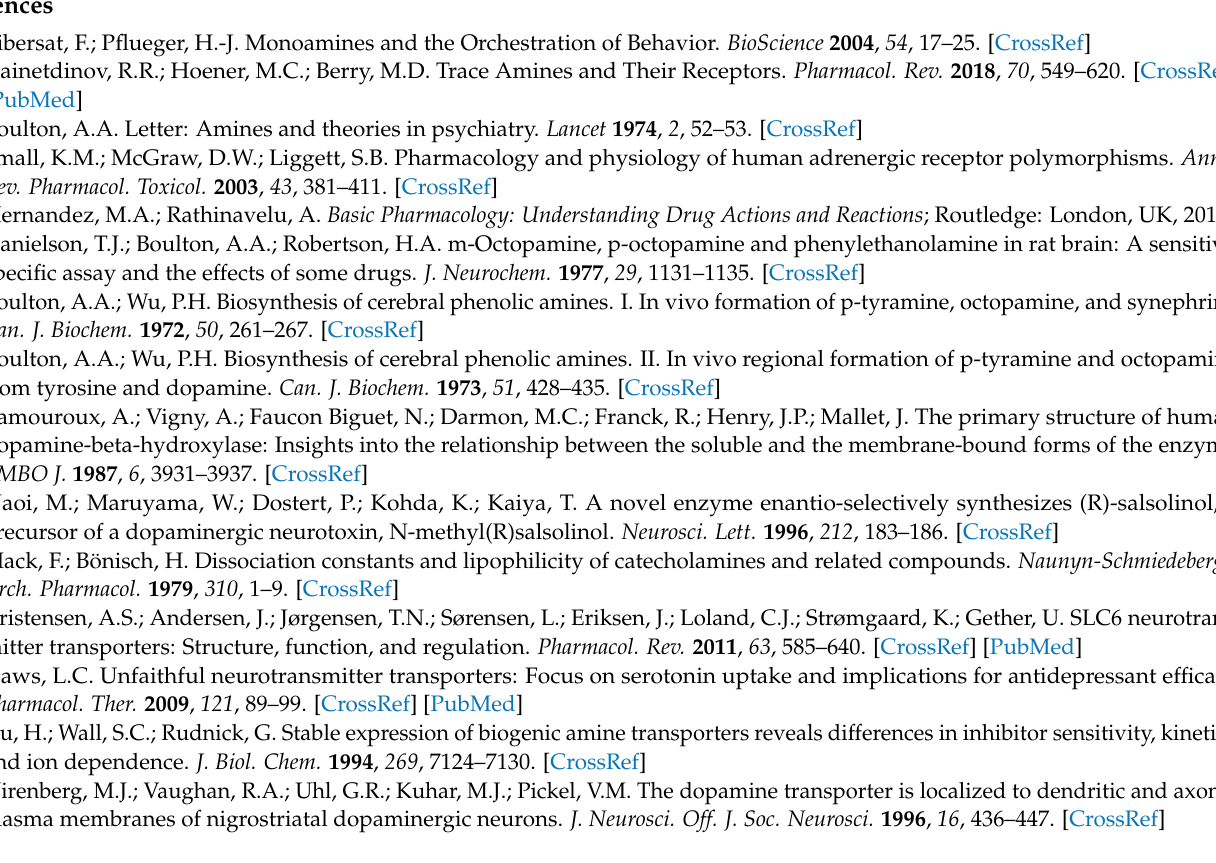
Figure S3: Net uptake curves of the serotonin transporter (SERT), Figure S4: Net uptake curves of the organic cation transporter 1 (OCT1), Figure S5: Net uptake curves of the organic cation transporter 2 (OCT2), Figure S6: Net uptake curves of the organic cation transporter 3 (OCT3); Table S1: HPLC conditions for chiral separation of investigated substances, Table S2: Mass spectrometry detection parameters, Table S3: Kinetic parameters for the stereoselective transport of chiral phenylethy- lamines by MATs and OCTs, Table S4: Stereoselectivity and transporter selectivity of investigated phenylethylamines for OCT2 and its A270S